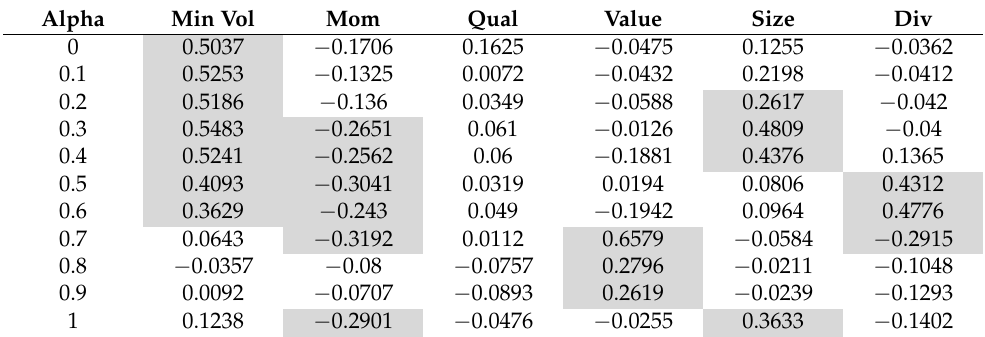
Table 6. Correlation between smart beta and VIX for all values of α . Highlighted values are those significantly different from zero—Pearson correlation. Period: January 2014–May